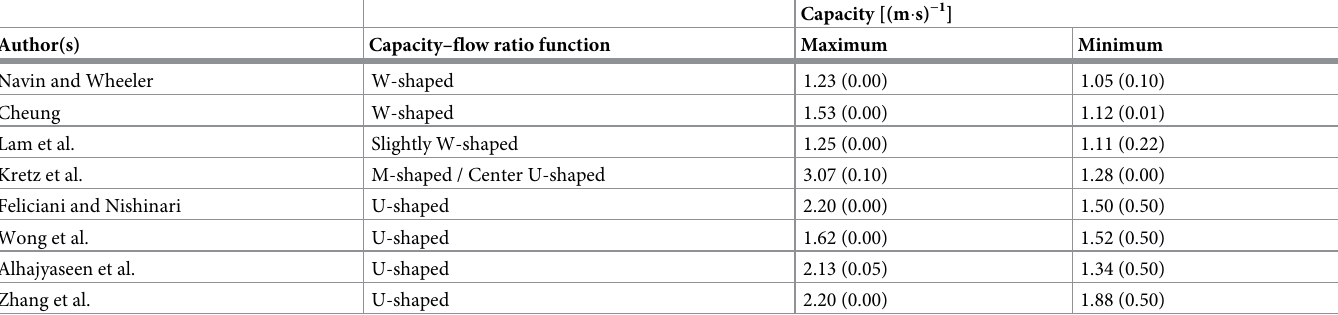
Table 1. Capacity–flow ratio relationship: Its shape and minimum/maximum capacity for different studies. Values given in bracket for capacity is the flow ratio at which minimum/maximum is observed; since the relation is symmetric two extrema are always found but only one is reported for